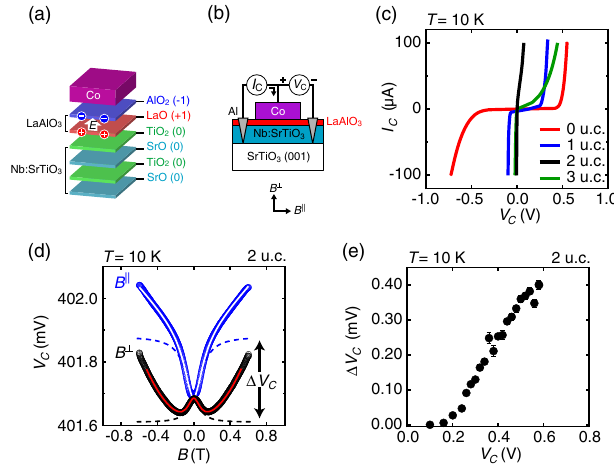
FIG. 1. Charge and spin transport across Co = LaAlO 3 = Nb ∶ SrTiO 3 heterojunctions with interface dipole layers. (a) Sche- matic diagram forstacking of1 u.c.LaAlO 3 ð 001 Þ insertedbetween Co and Nb ∶ SrTiO 3 ð 001 Þ . (b) Schematic diagram of the measure- ment configuration. (c) I vs V for different t . (d) Typical C C LAO ¼ 2 u : c : , I ¼ 2 . 8 mA) as a junction dc magnetoresistance ( t C LAO function of B ⊥ (black) and B ∥ (blue). Dashed lines indicate the Lorentzian component, while solid lines show the best fit including the background. (e) Bias dependence of the total Lorentzian